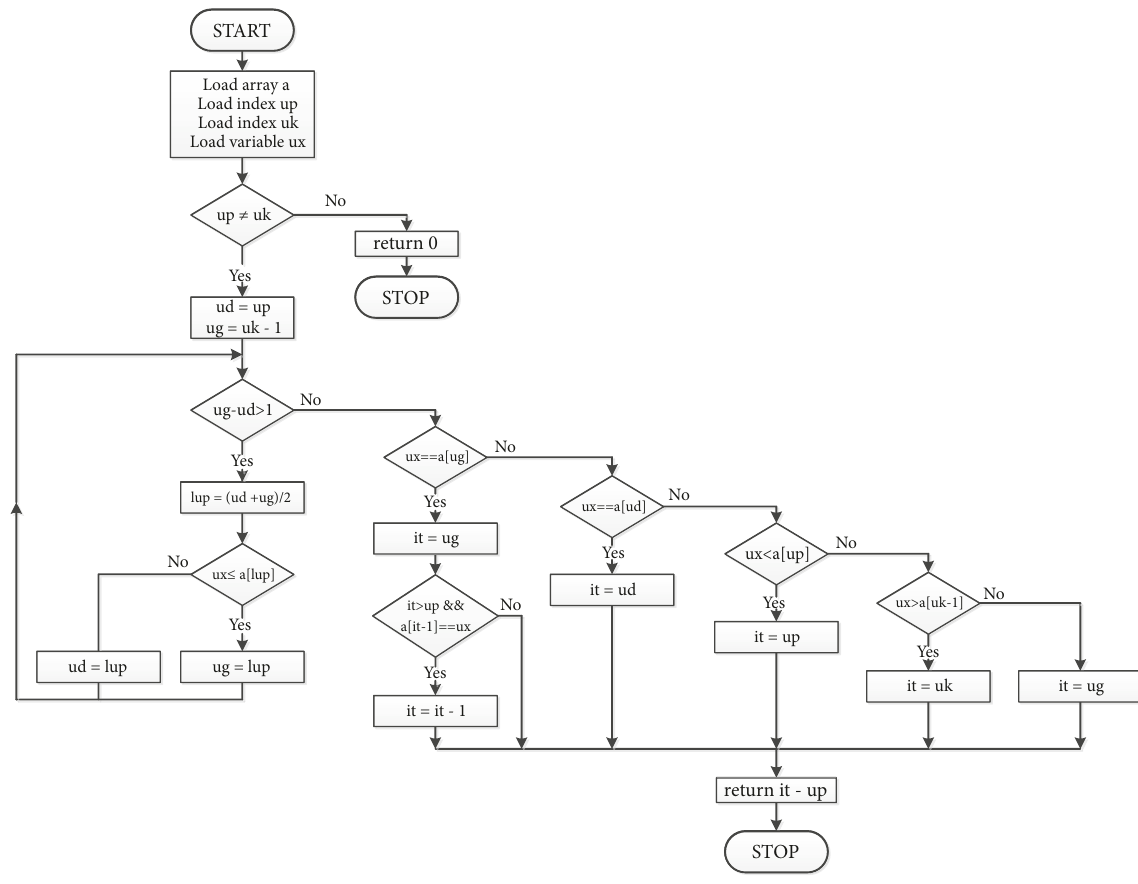
Figure 10: The block diagram of the function which returns index located in the right